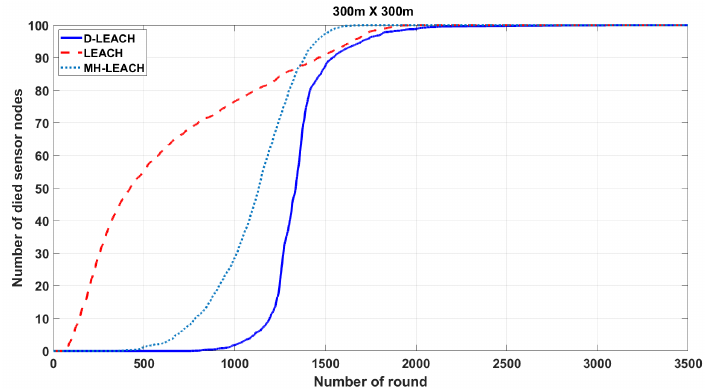
Figure 15. The number of dead sensor nodes in WSNs (300 × 300 m 2 ).